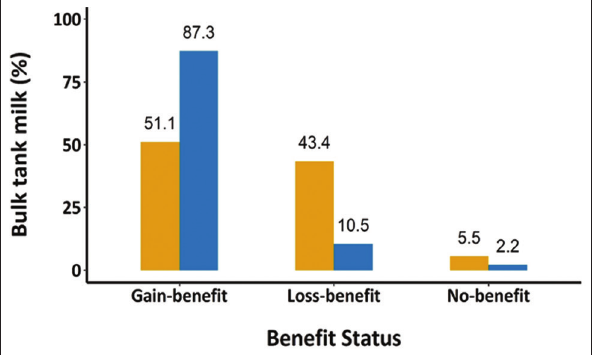
Figure-3: The percentage of bulk tank milk taken from the central (yellow) and northern (blue) regions categorized by the final payment groups, including gain-benefit, loss- benefit, and no benefit groups. Table-2: Primary patterns of payment classes and milk components in bulk tank milk from the central region of Thailand.